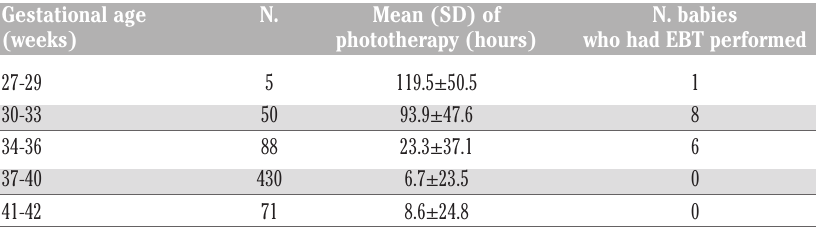
Table 3. Mean duration of phototherapy (SD) and number of EBT performed in each ges- tational age group.